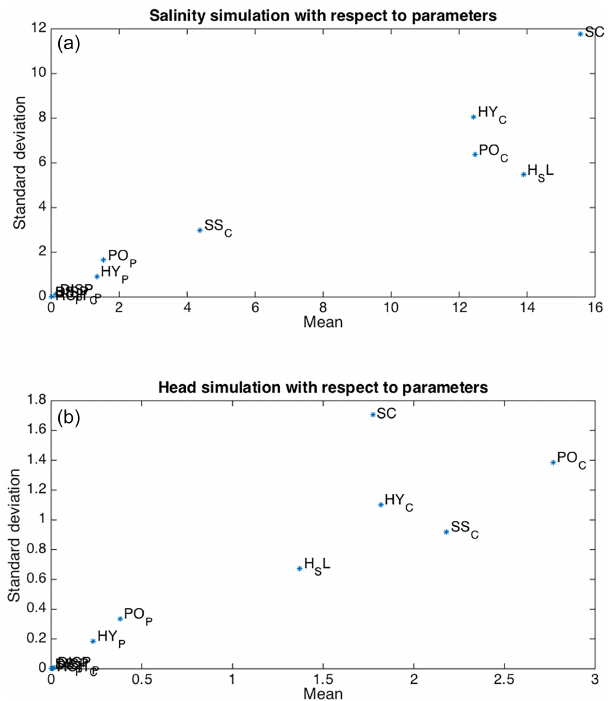
Figure 10. Mean and standard deviation of the EEs (elementary ef- fects) of parameters with respect to simulations in the conduit (col- umn no. 50, layer no. 29) in the global sensitivity analysis by the Morris method: (a) salinity simulation (top); (b) head simulation